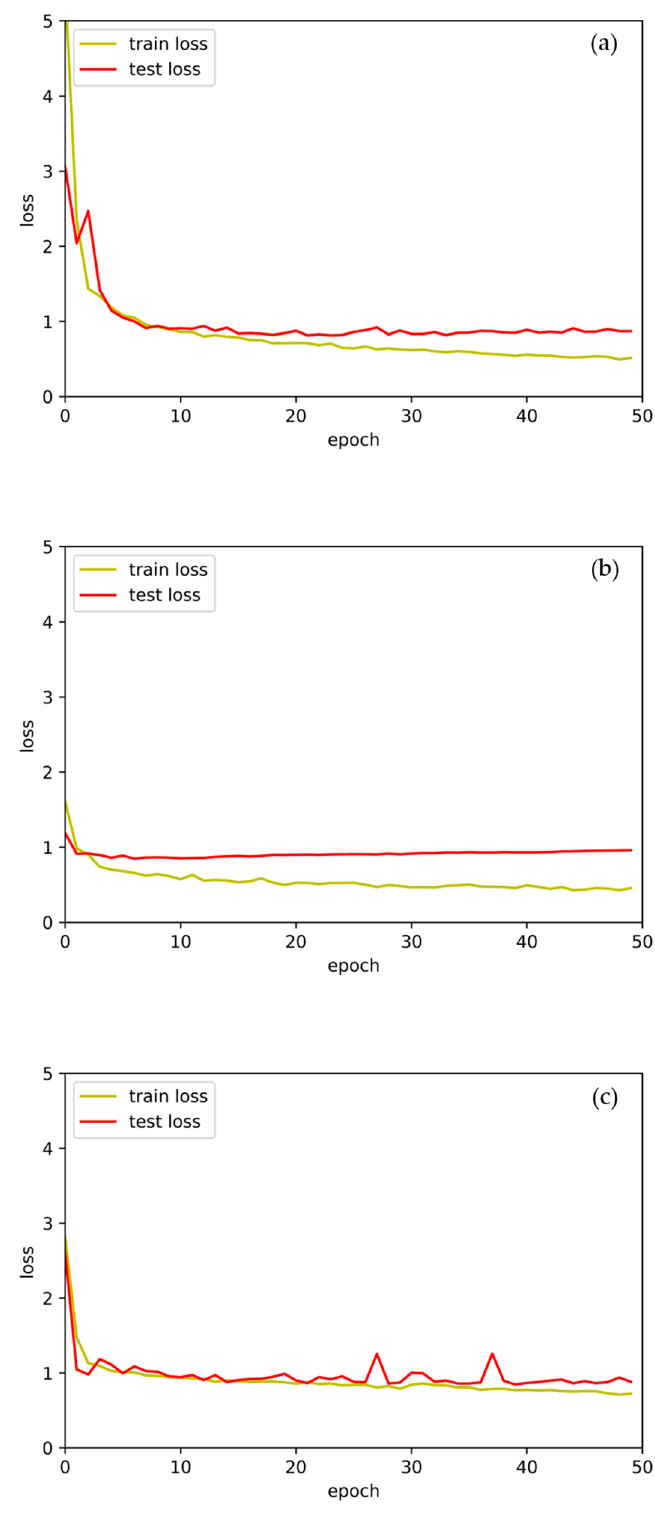
Figure 9. Examples of training and test loss for each deep learning model: ( a ) DNN-based model; Figure 9. Example s of training and test loss for each deep learning model: (a) DNN-based model; (b) ( b ) CNN-based model; ( c ) RNN-based CNN-based model; (c) RNN-based model.